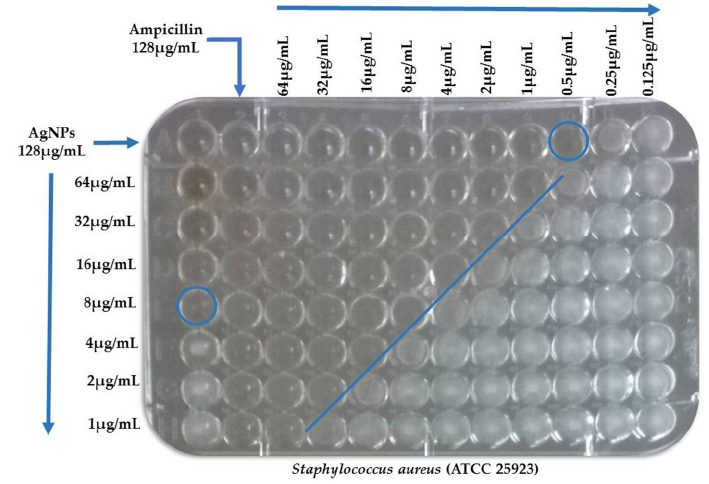
Figure 4. Example of checkerboard testing. Blue circles denote the MIC of antimicrobial agents (alone) and blue line denote the FIC (combination of both). MIC: Minimum Inhibitory Concentration. FIC: Fractional Inhibitory Concentration. Table 3. FIC index of combinations among silver nanoparticles and antibiotics against clinical and reference strains.